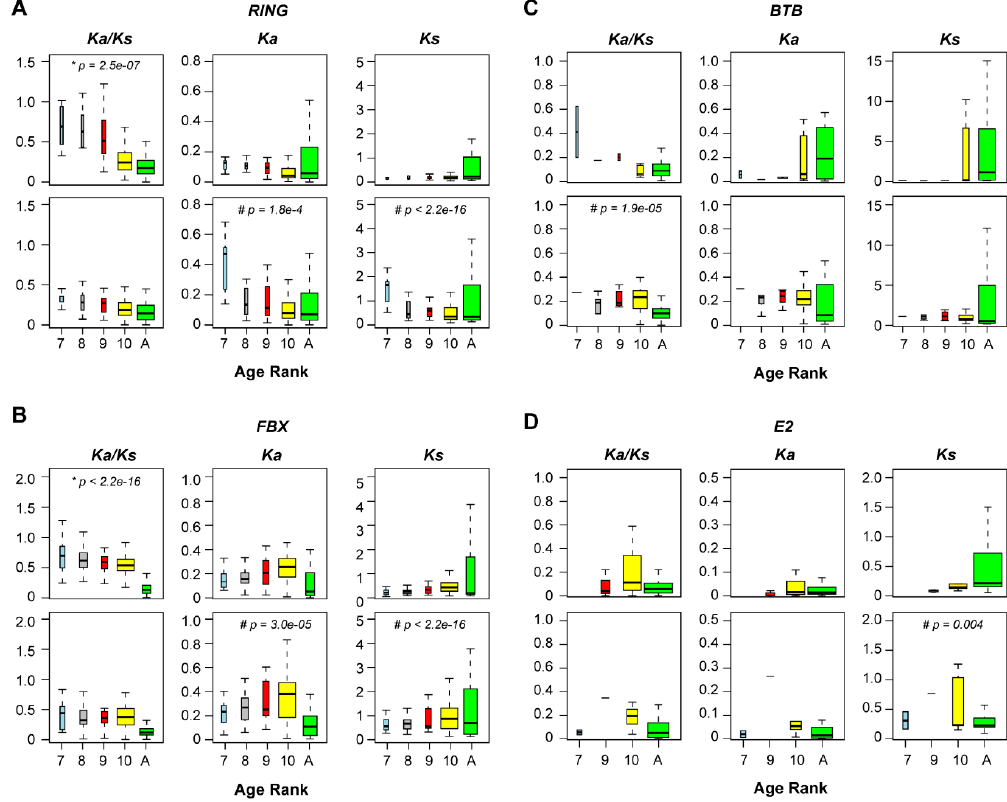
Figure 4. Evolutionary selection analysis of age-ranked orthologous genes from four large UPS gene families. Age ranked orthologous Aly – Ath (top panel) and Osa – Obr (bottom panel) pairs were